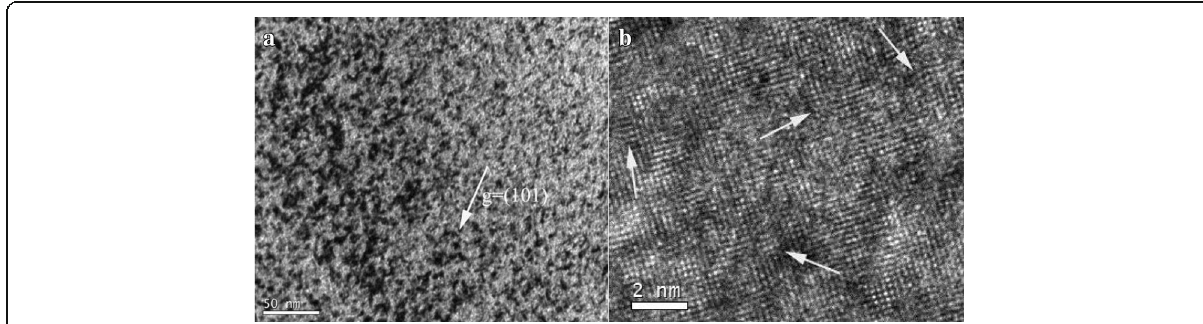
Fig. 1 Images of V-4Cr-4Ti alloys after He+H ion irradiation sequentially at RT. a TEM bright-field image of defects. b HRTEM image of defects